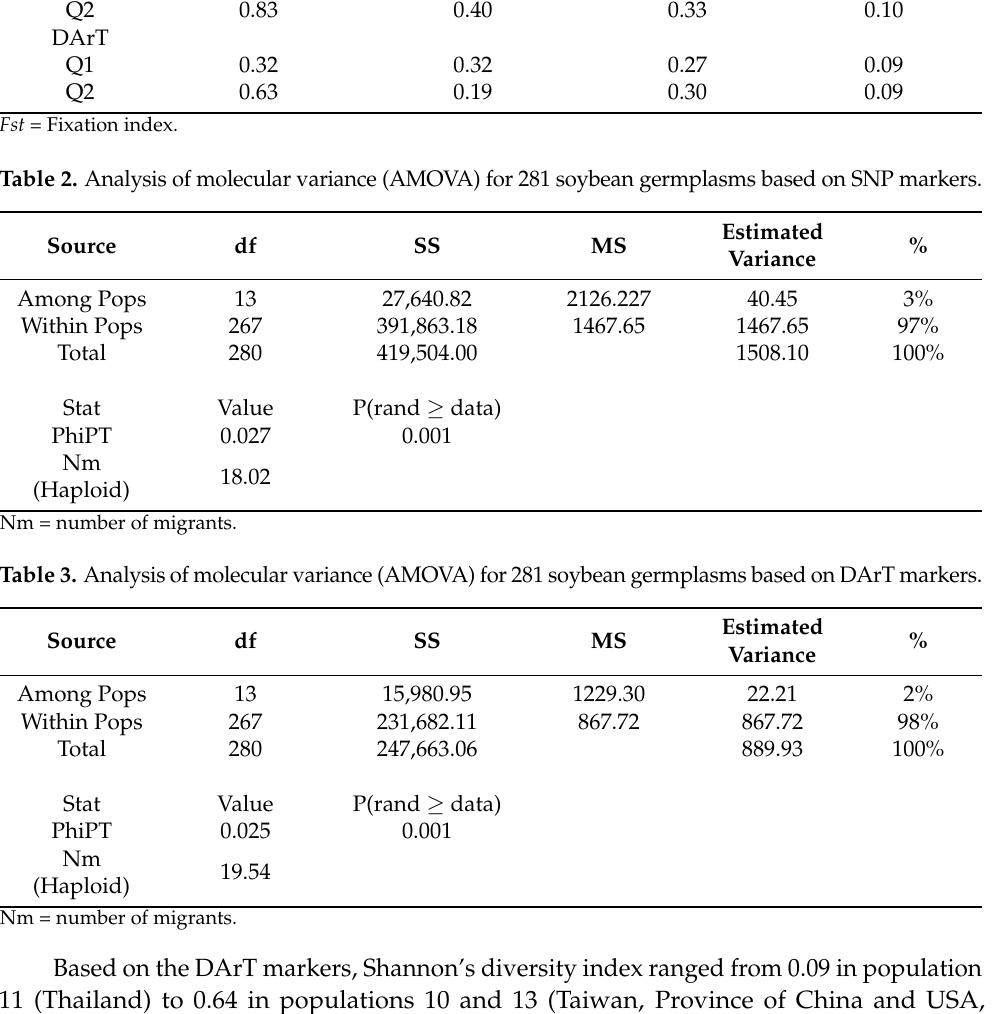
Table 1. Model-based Bayesian analysis of the SNP and DArT markers.